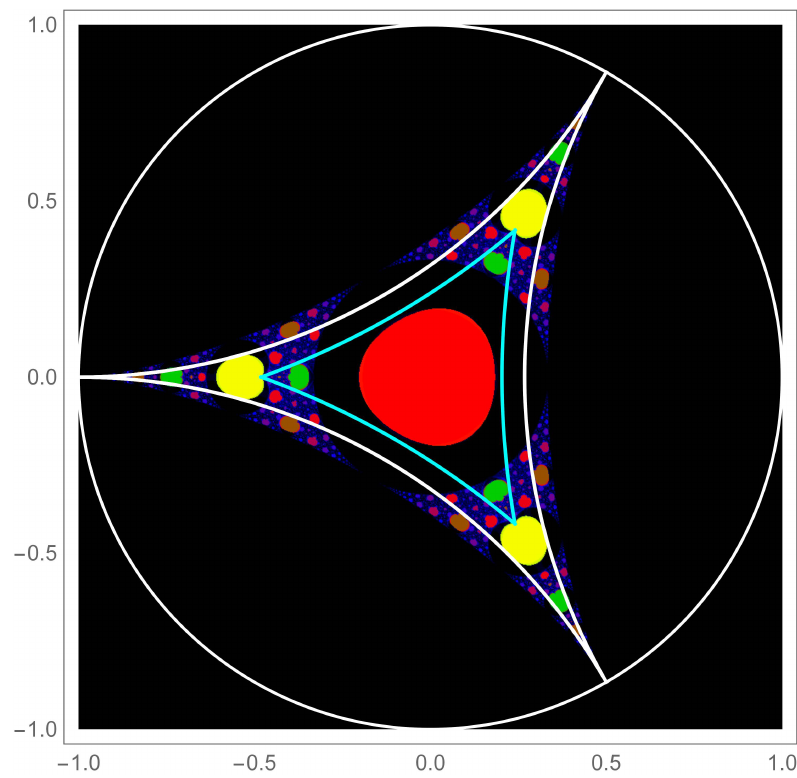
Figure 2. Hyperbolic geometric features of 100 h ( U ) ( z ) . When the ideal regular triangle (white) is inscribed on the unit disk, the hyperbolic geodesics are tangent to the three larger orbiting